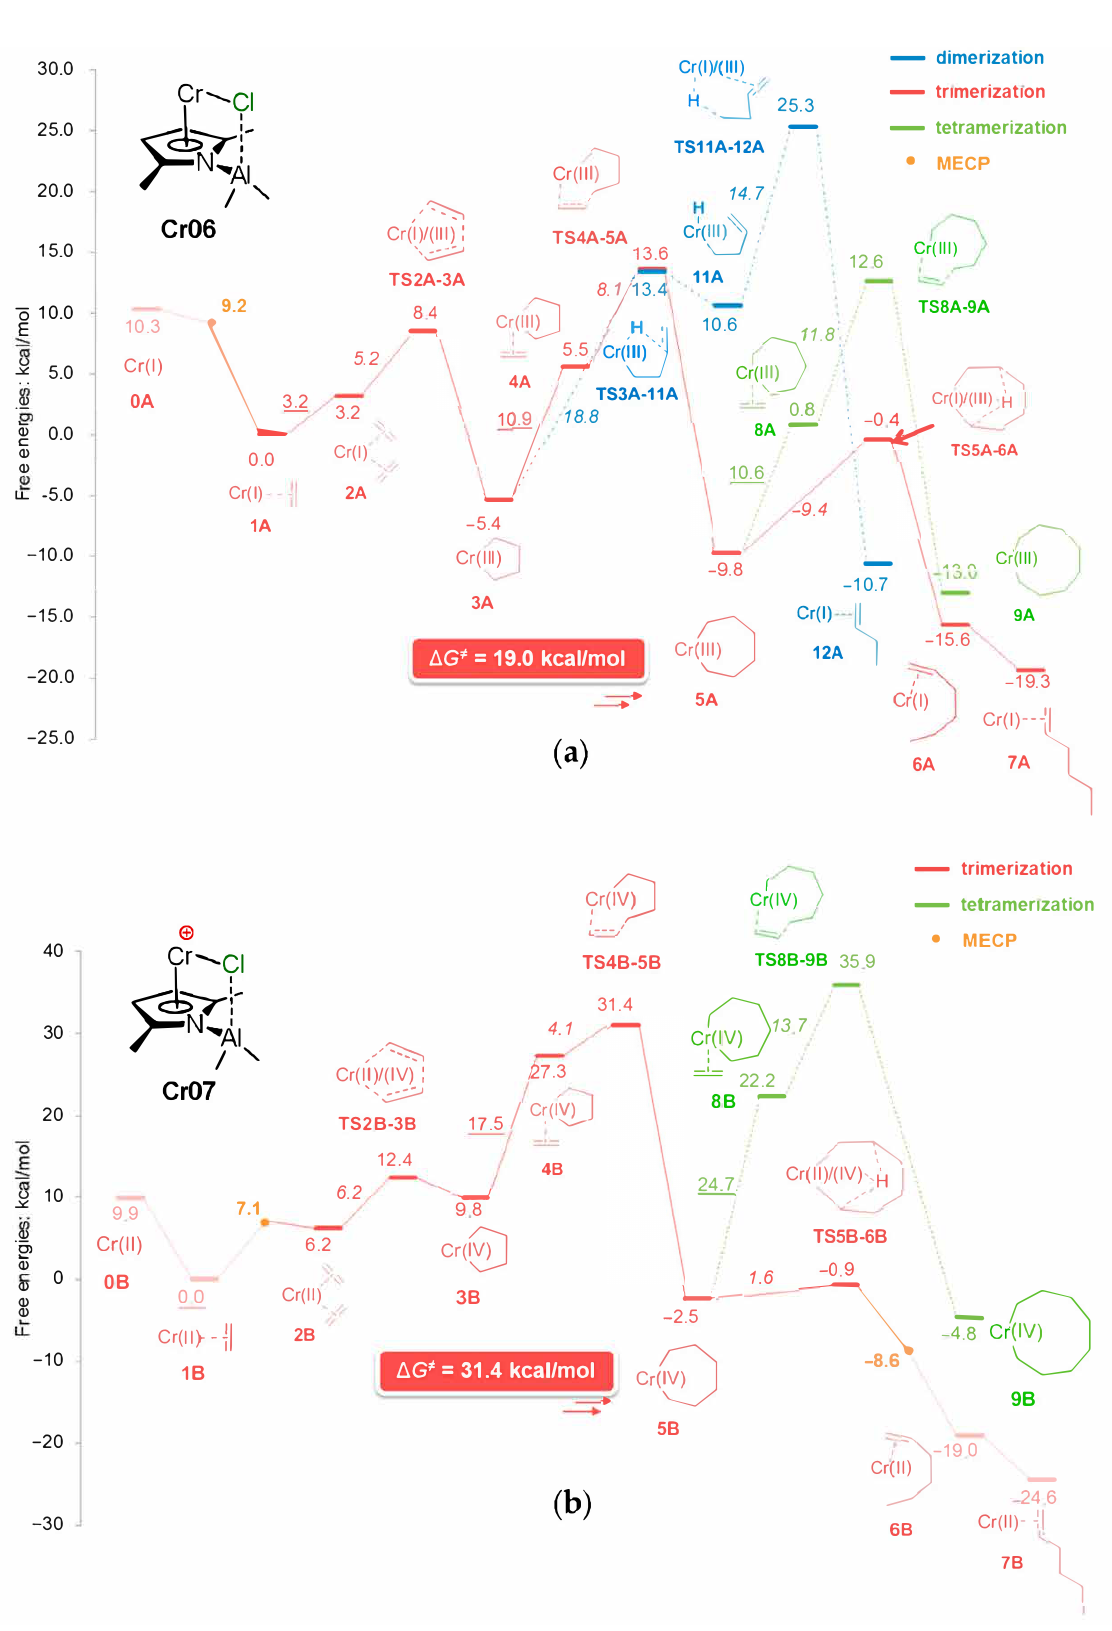
Figure 29. Calculated free energy diagram for model catalytic species Cr06 ( a ) and Cr07 ( b ). Me 2 Al fragments are omitted. Reprinted with permission from [238]. Copyright (2014) Ameri- can Chemical